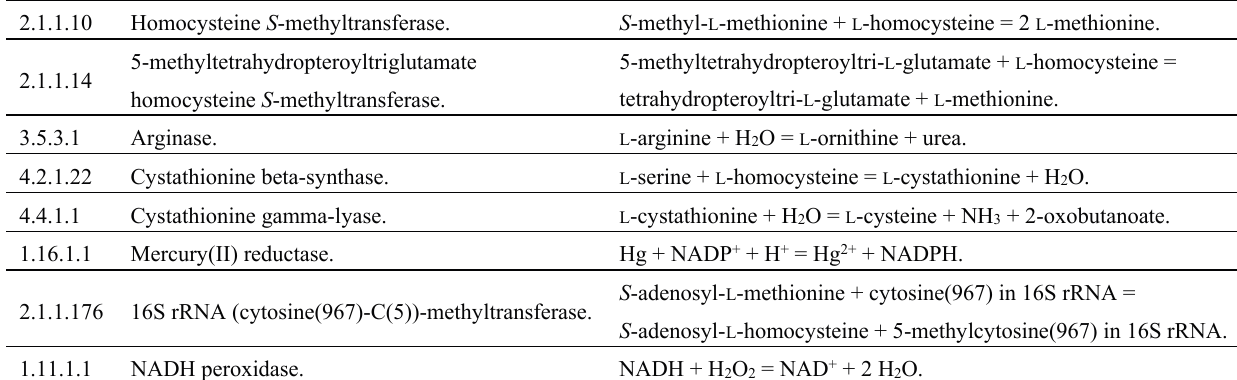
Table 8. Enzymes of interest coded by Lactobacillus acidophilus: Query